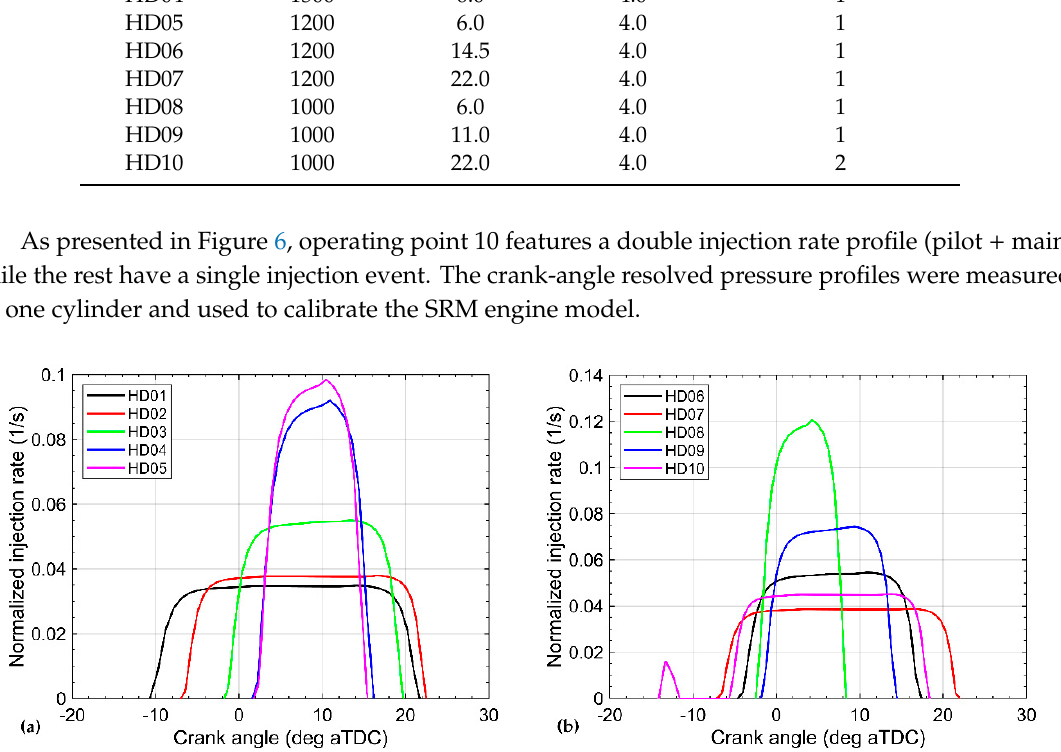
Table 3. Liquid properties of the experimental and surrogate fuel mixture used in the heavy-duty Diesel engine simulation campaign.